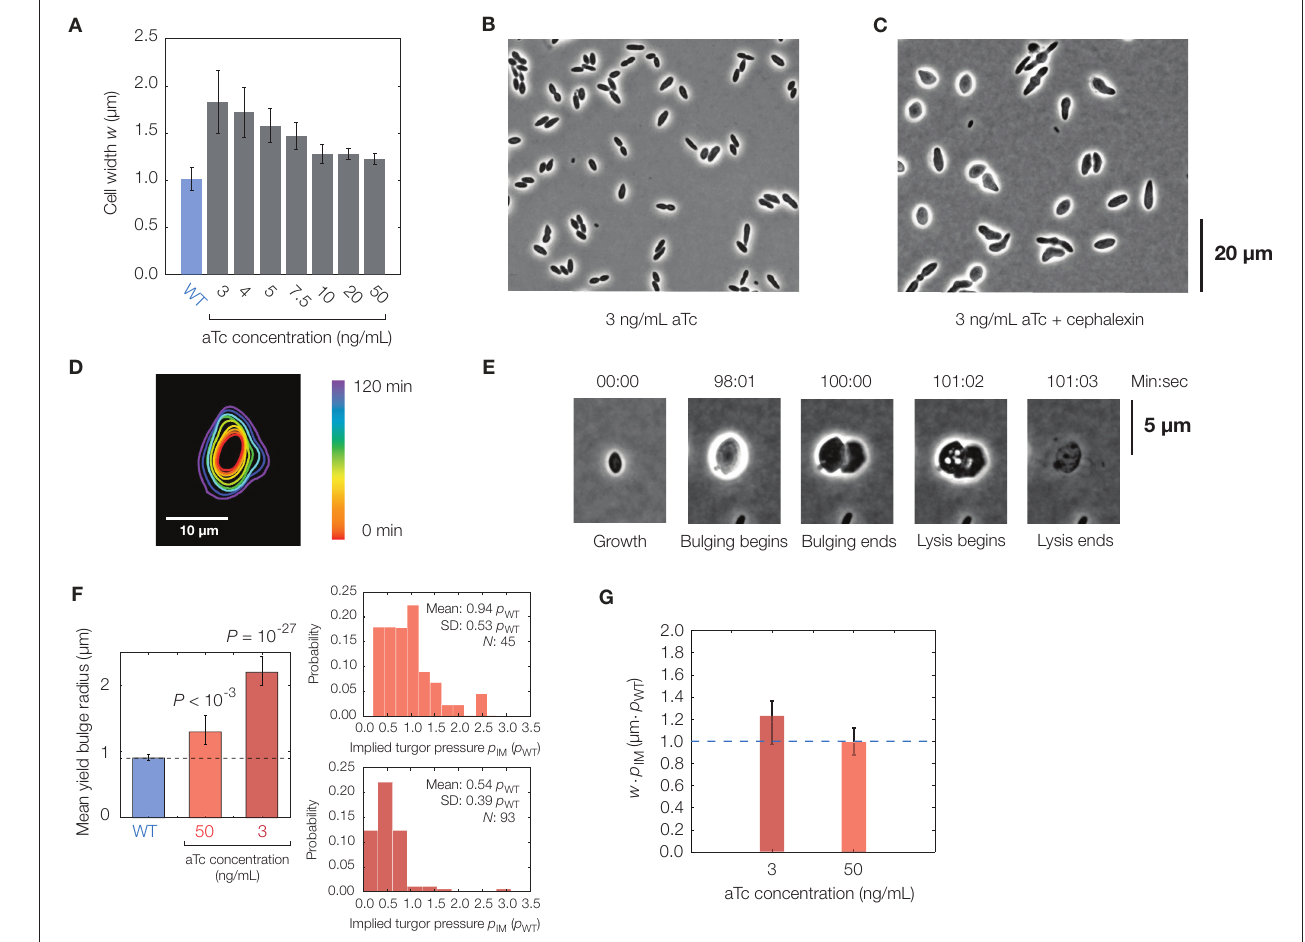
FIGURE 4 | Effects of cell shape changes on lysis. (A) Plot of mean cell width against aTc concentration in the mreB -titratable strain (strain ZH1) and for wild-type (parent strain AMB1655) cells. Error bars indicate one standard deviation, and each bar represents at least 100 cells. (B) Phase-contrast image of a population of mreB -titratable cells, at an aTc concentration of 3 ng/mL, without cephalexin treatment. (C) Same as (B) , but for 2 h after cephalexin treatment, showing that most cells lose their rod shapes. (D) Contour image of a representative mreB -titratable cell, at an aTc concentration of 3 ng/mL, which does not bulge or lyse over 2 h. (E) Lysis dynamics of a representative mreB -titratable cell, at an aTc concentration of 3 ng/mL, during cephalexin treatment, with labeling corresponding to Figure 1D . For a full timelapse of a lysing population, see Supplementary Movie 6 . (F) Comparison of mean yield bulge radii between WT and mreB -titratable cells. Error bars indicate 95% confidence intervals, and p -values refer to two-sample Kolmogolrov-Smirnov tests for the difference from wild-type (dashed line). The accompanying distributions of implied turgor pressures p IM , expressed in units of turgor pressure in wild-type cells, p WT , is shown at right. See section 2 for details of the calculation. (G) Plot of the product of cell width, w , and implied turgor pressure, p IM , against aTc concentration in the mreB -titratable strain. Error bars represent 95% confidence intervals, and each point represents calculations based on measurements from at least 45 cells. The blue dashed line, shown for comparison, represents the value of w · p IM expected for a wild-type cell with a cell width of 1 µ